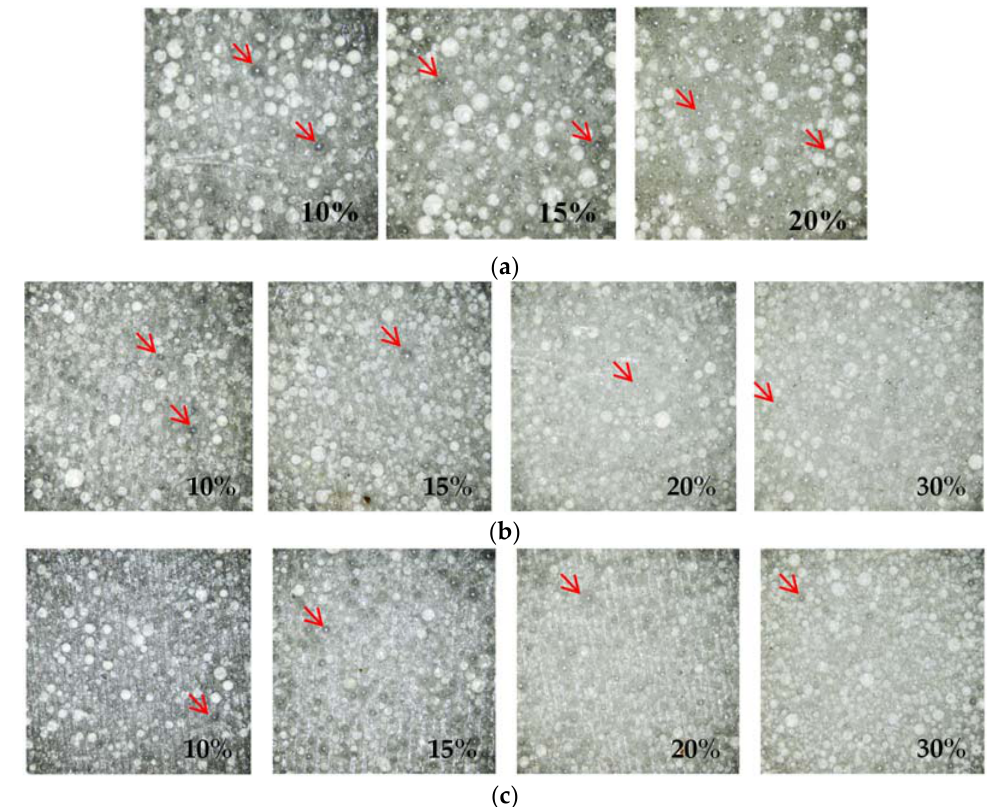
Figure 5. Microstructure of the epoxy/hollow glass microsphere composites. ( a ) BR20, ( b ) BR40, and ( c ) BR60 microsphere. (The value on the figure is the weight ratio R c , the red arrows are the air bubble).